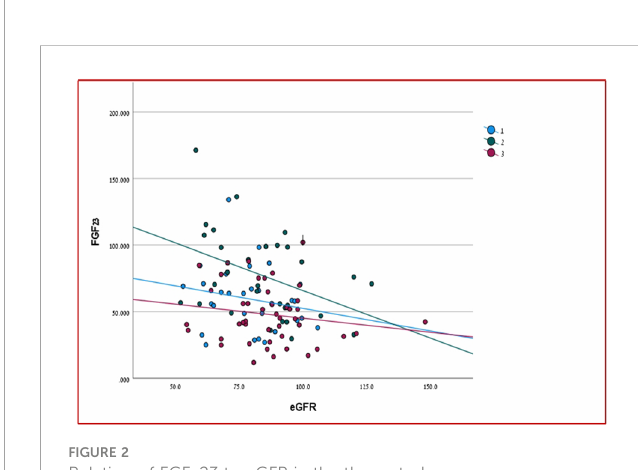
FIGURE 2 Relation of FGF-23 to eGFR in the three study groups.